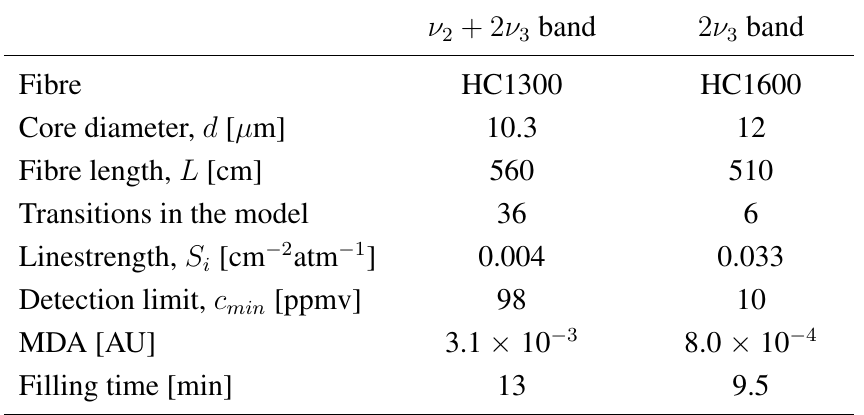
Table 2. Comparative of the results of methane detection using HC1300 and HC1600